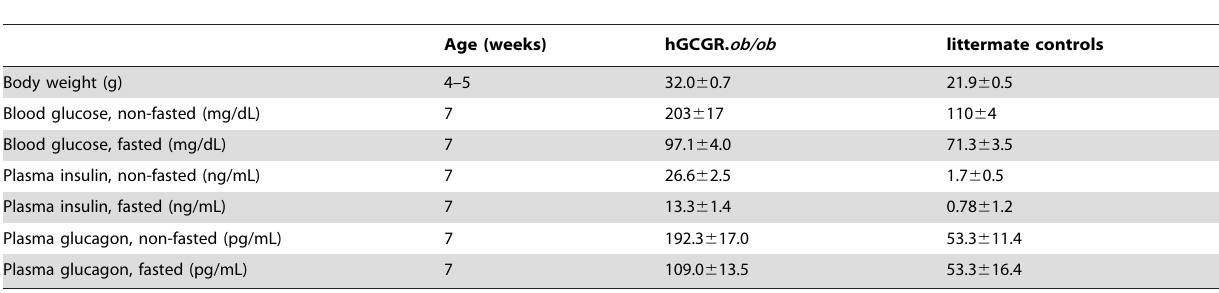
Table 3. The diabetic phenotype of the hGCGR. ob/ob mouse.